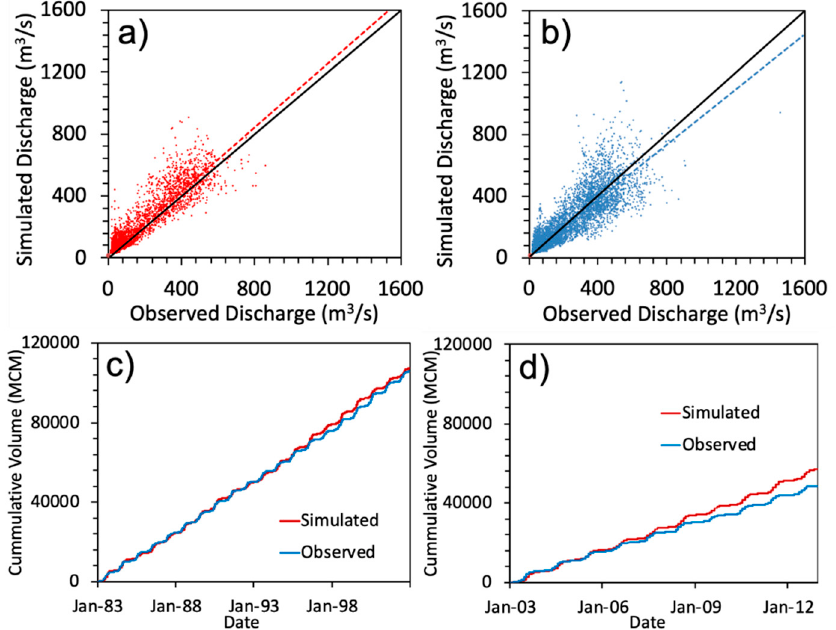
Figure 6. Scattered plots for daily flow in ( a ) calibration and; ( b ) validation; cumulative volume balance in the ( c ) calibration period; and the ( d ) validation period.